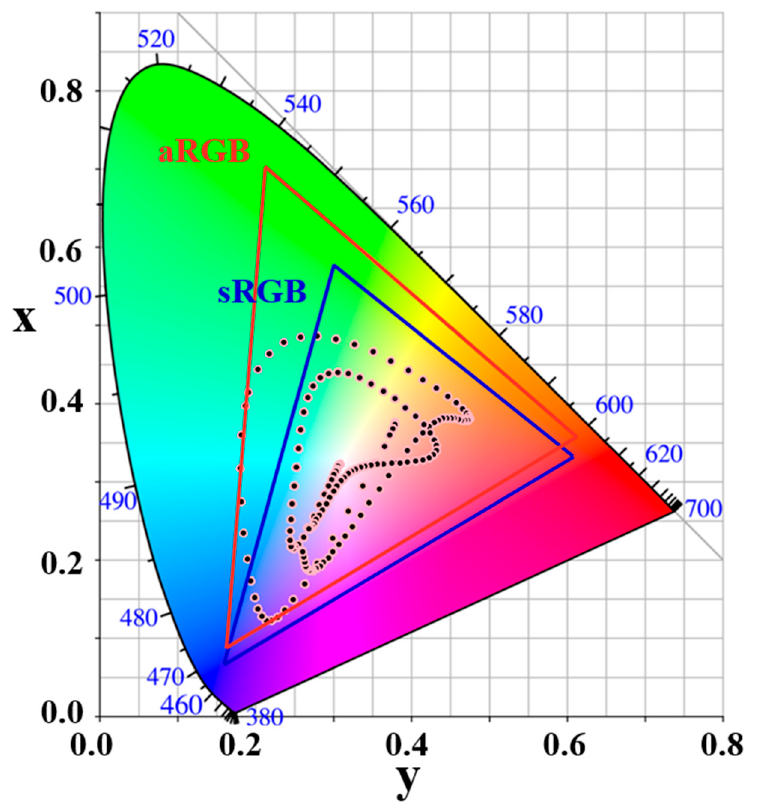
Figure 10. The corresponding CIE 1931 chromaticity coordinates are based on simulated spectra.